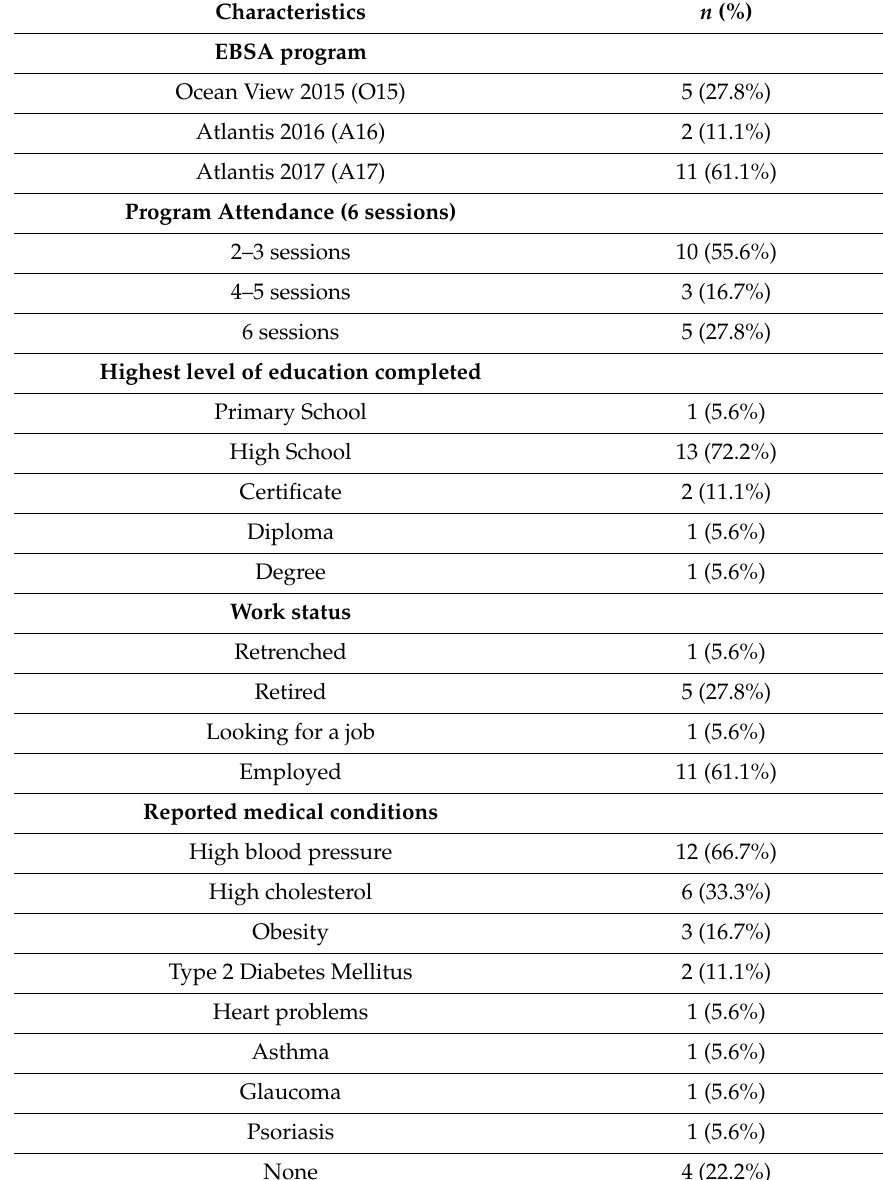
Table 1. Participant characteristics ( n = 18).